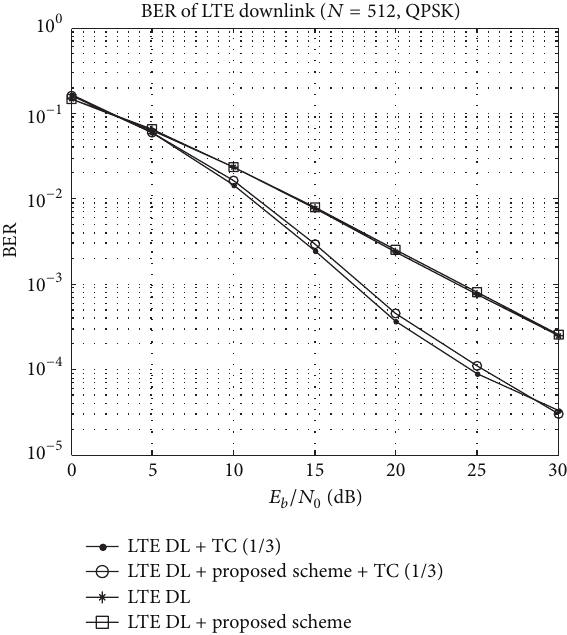
Figure 5: CCDF comparison as a function of WHT and randomly generated sequence ratio.